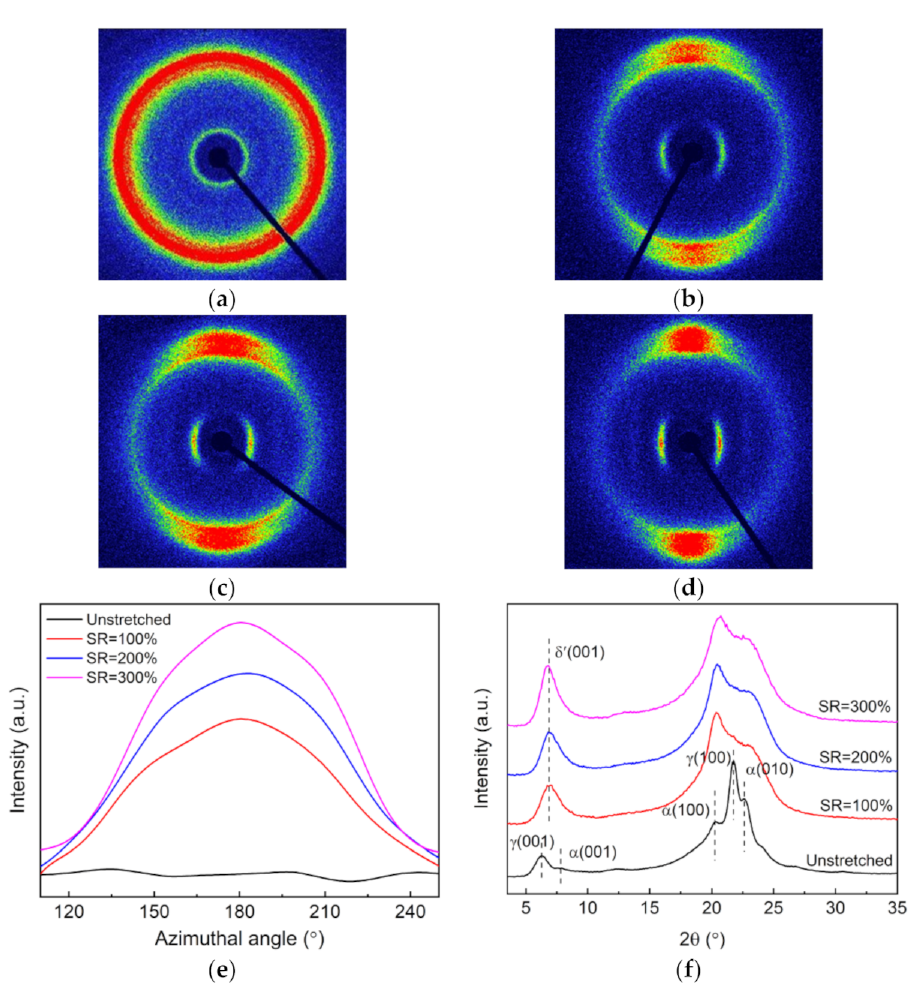
Figure 1. 2D-WAXD patterns of the nylon-11 films: ( a ) unstretched and ( b – d ) stretched at 80 ◦ C with different stretching ratios (SR): ( b ) 100%, ( c ) 200% and ( d ) 300%; ( e ) azimuthal intensity distributions of the (001) reflection, and ( f ) diffraction intensity profiles derived from the 2D-WAXD